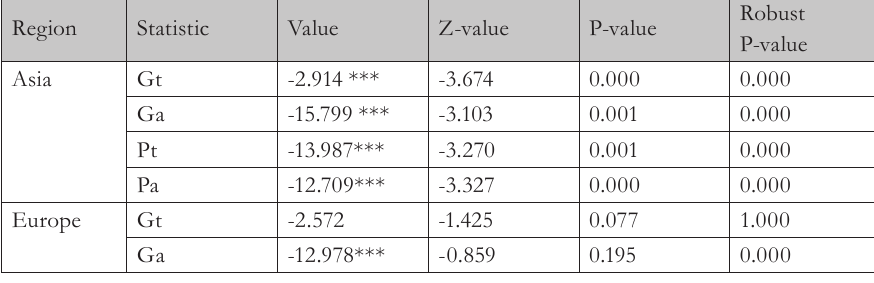
Tab. 2 – Westerlund panel cointegration test results. Source: own